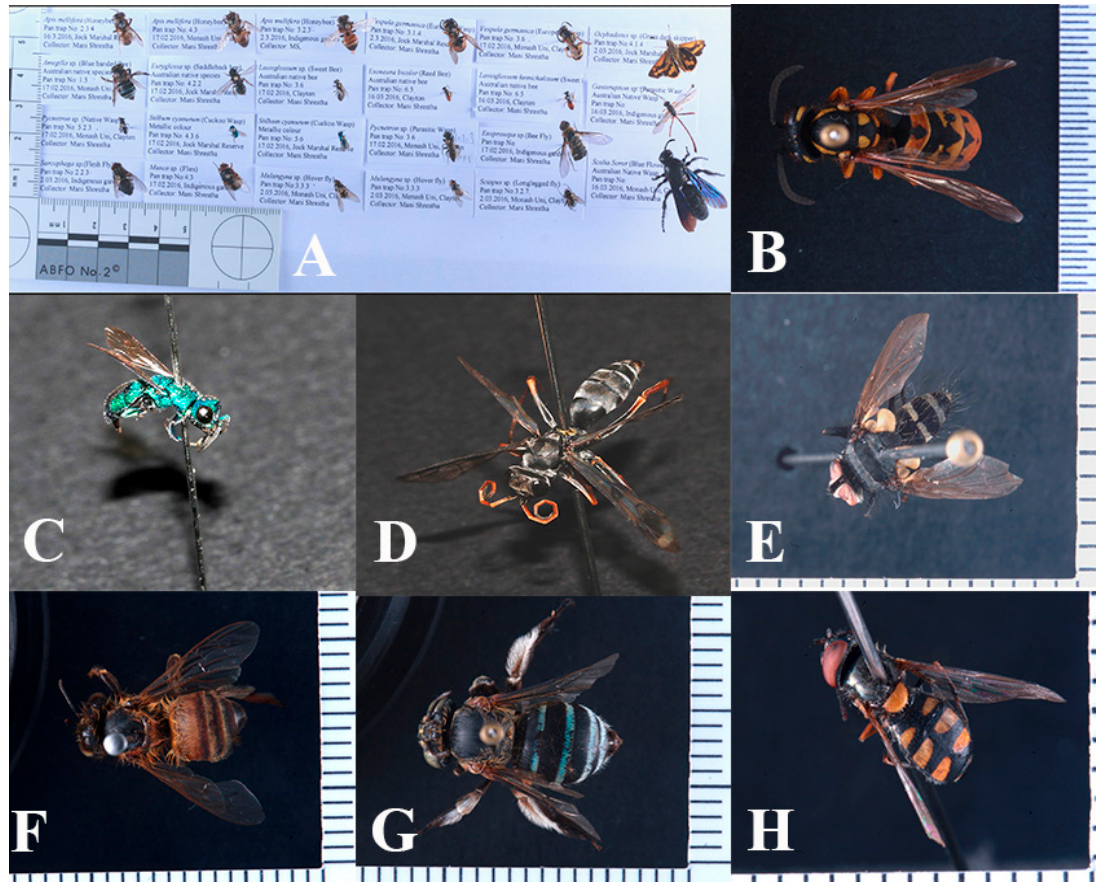
Figure 4. Sample insects captured by the pan traps: ( A ) Array of pinned insect samples, ( B ) European wasp ( Vespula germanica ), ( C ) cuckoo wasp ( Stibum cyanurum ), ( D ) male winged ant ( Myrmecia urens ), ( E ) long-legged fly ( Sciapus sp.), ( F ) honey bee ( Apis mellifera ), ( G ) blue-banded bee ( Amegilla sp.), and ( H ) hoverfly ( Melagyna sp.). Images © Copyright M.S. and J.H.C.H.